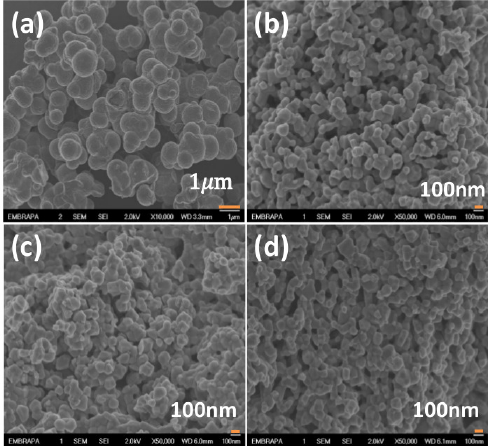
Figure 4. SEM micrographs of Nb 2 O 5 : ( a ) Sol-gel (NH 4 OH) Nb 2 O 5 —750 ◦ C for a resolution of 1 µ m; ( b ) Pechini (NH 4 OH) Nb 2 O 5 —750 ◦ C for a resolution of 100 nm; ( c ) Pechini (HCl) Nb 2 O 5 —750 ◦ C for a resolution of 100 nm; and ( d ) pechini (HNO 3 ), Nb 2 O 5 —750 ◦ C for a resolution of 100